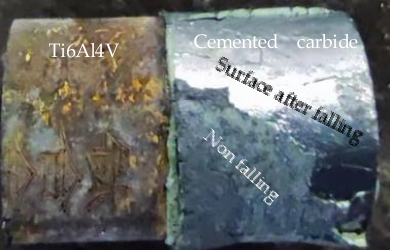
Figure 8. Element diffusion between the cemented carbide and the Ti6Al4V at different holding temperatures. ( a ) Diffusion of the W element; ( b ) Diffusion of the Co element; ( c ) Diffusion of the Ti element.